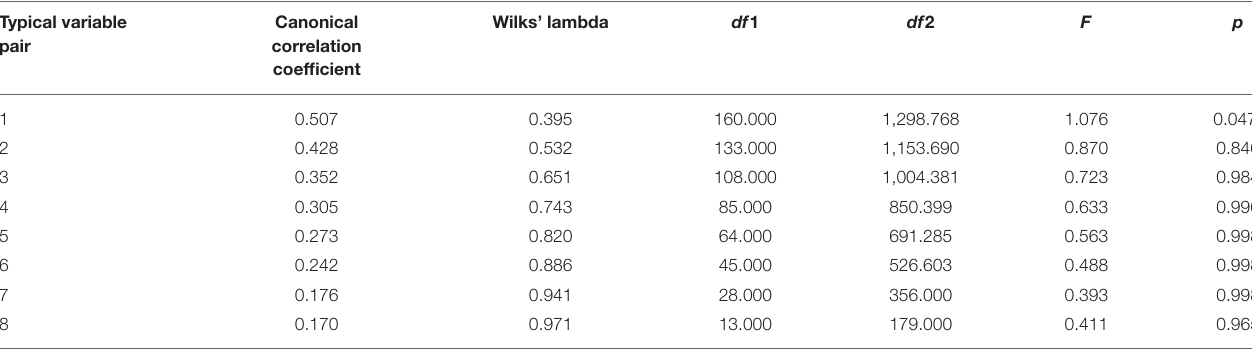
TABLE 6 | Typical correlation coefficients and significance of motor behavior and motor